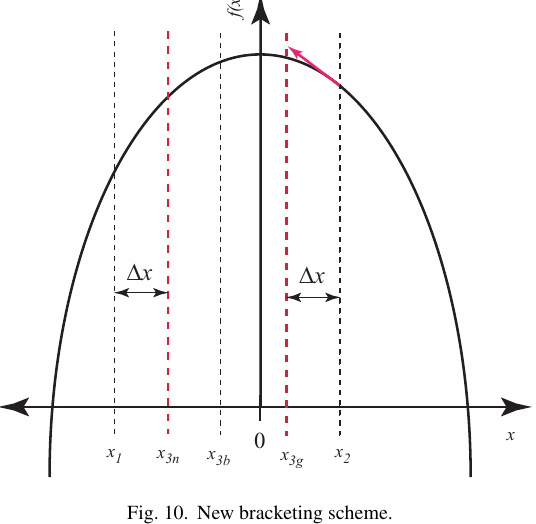
Fig. 10. New bracketing scheme.